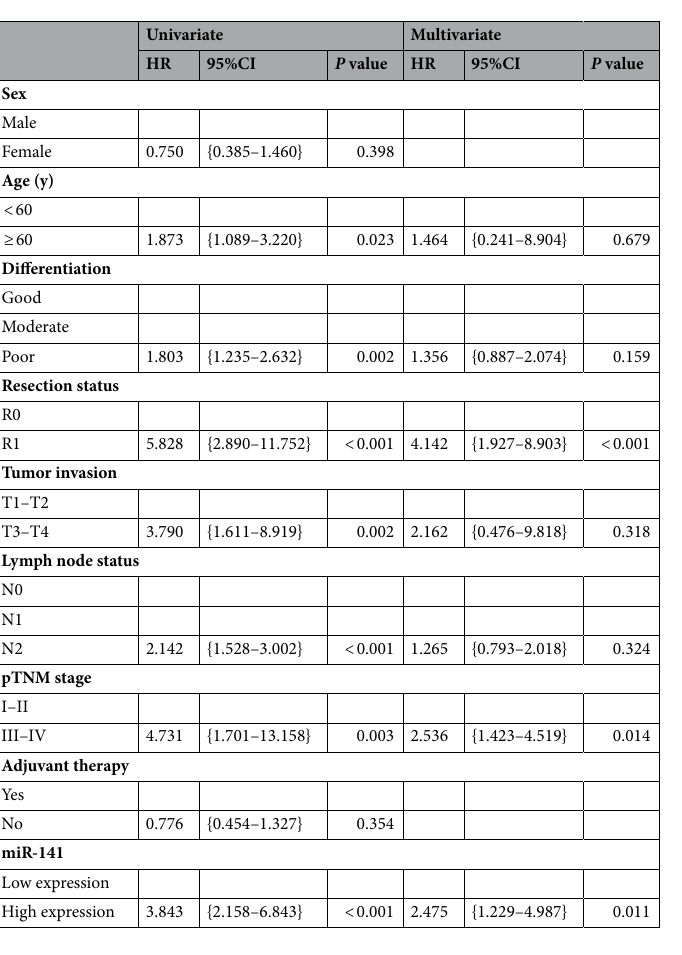
Table 2. Univariate and multivariate analysis for prognostic factors of GBC. HR hazard ratio, CI confidence interval, pTNM pathological tumor/node/metastasis, GBC gallbladder cancer.